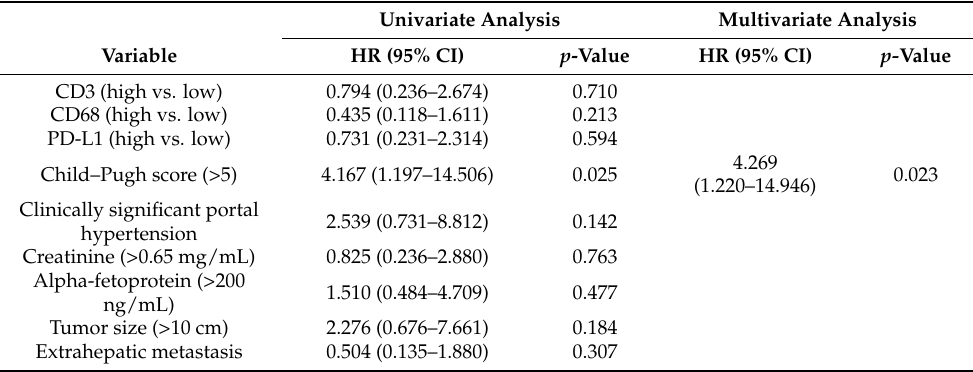
Table 3. Factors associated with overall survival analyzed by Cox regression analysis.